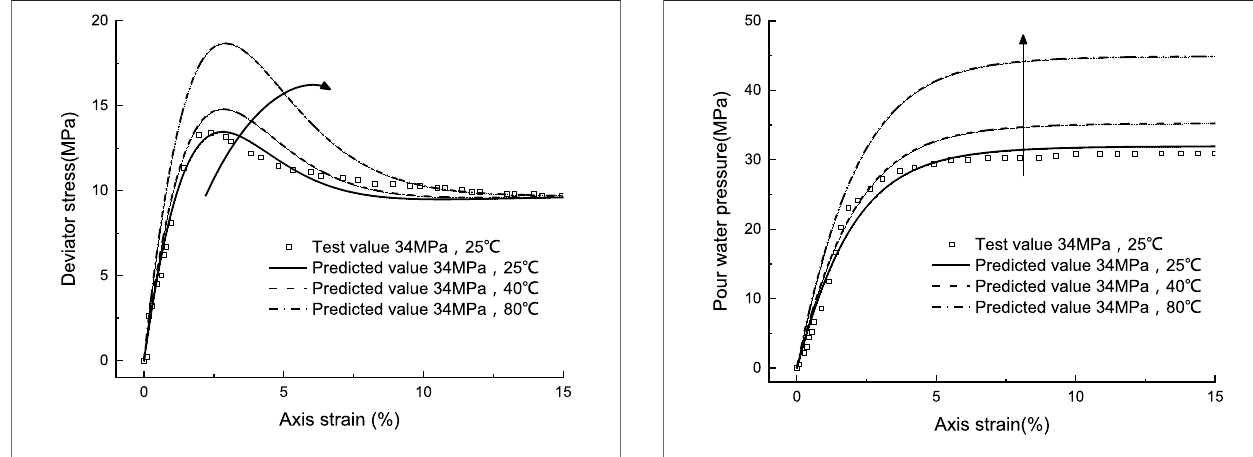
Figure 4 indicated that the stress-strain curves of sandy soil with different initial densities have similar changing trends.